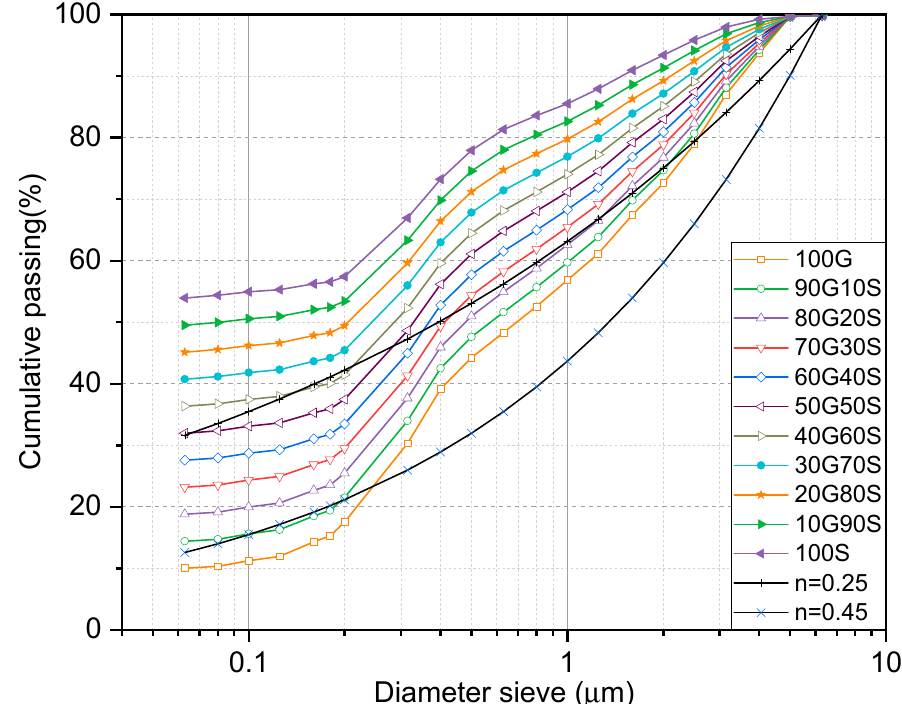
Figure 3. Mix grain size distribution and optimal reference curves.